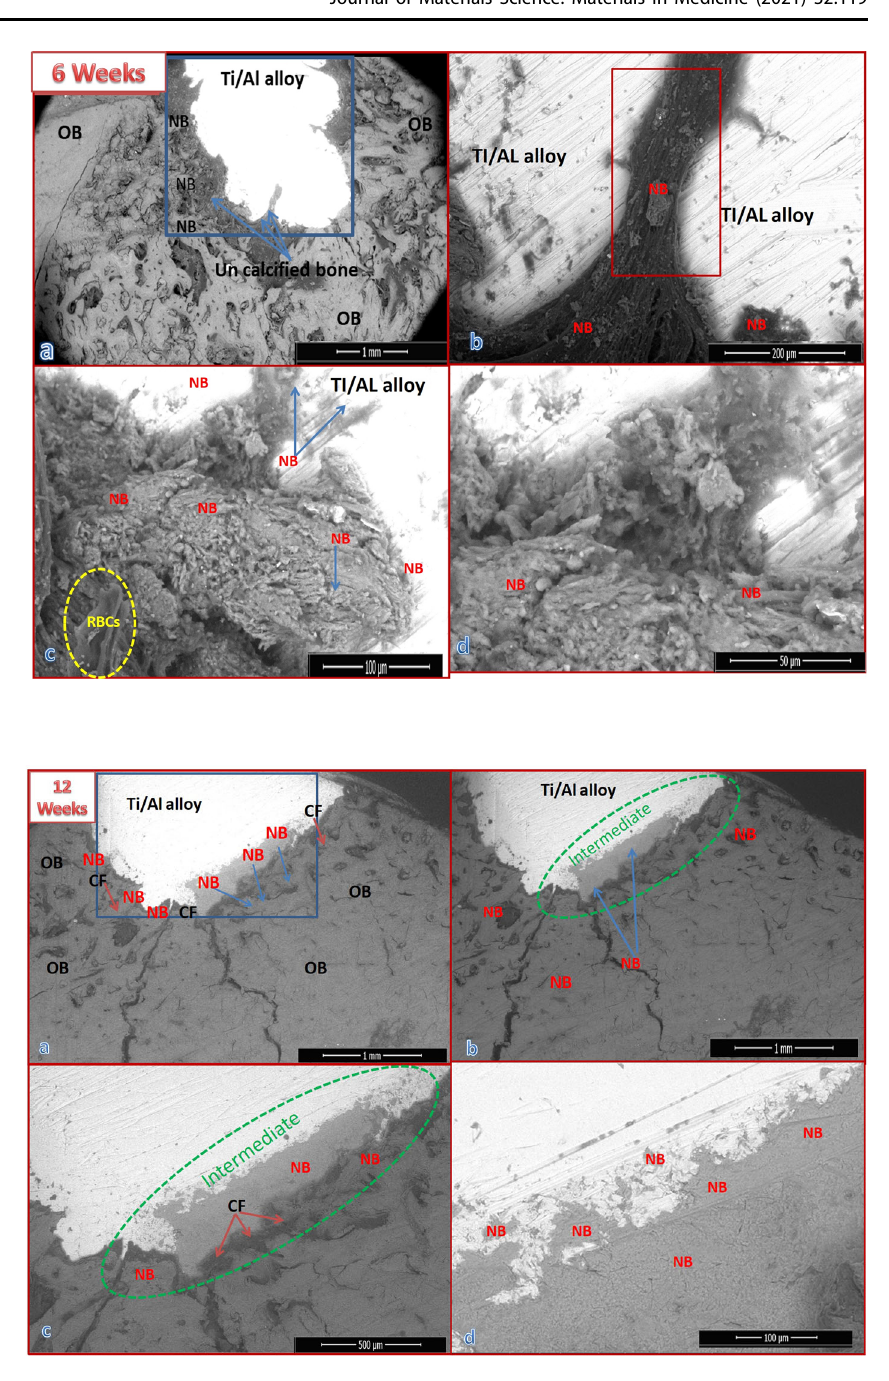
Fig. 5 SEM micrographs with different magni fi cations for a cross-section of bone defect drilled in the dog femurs and grafted with uncoated Ti/Al alloy (control group) for